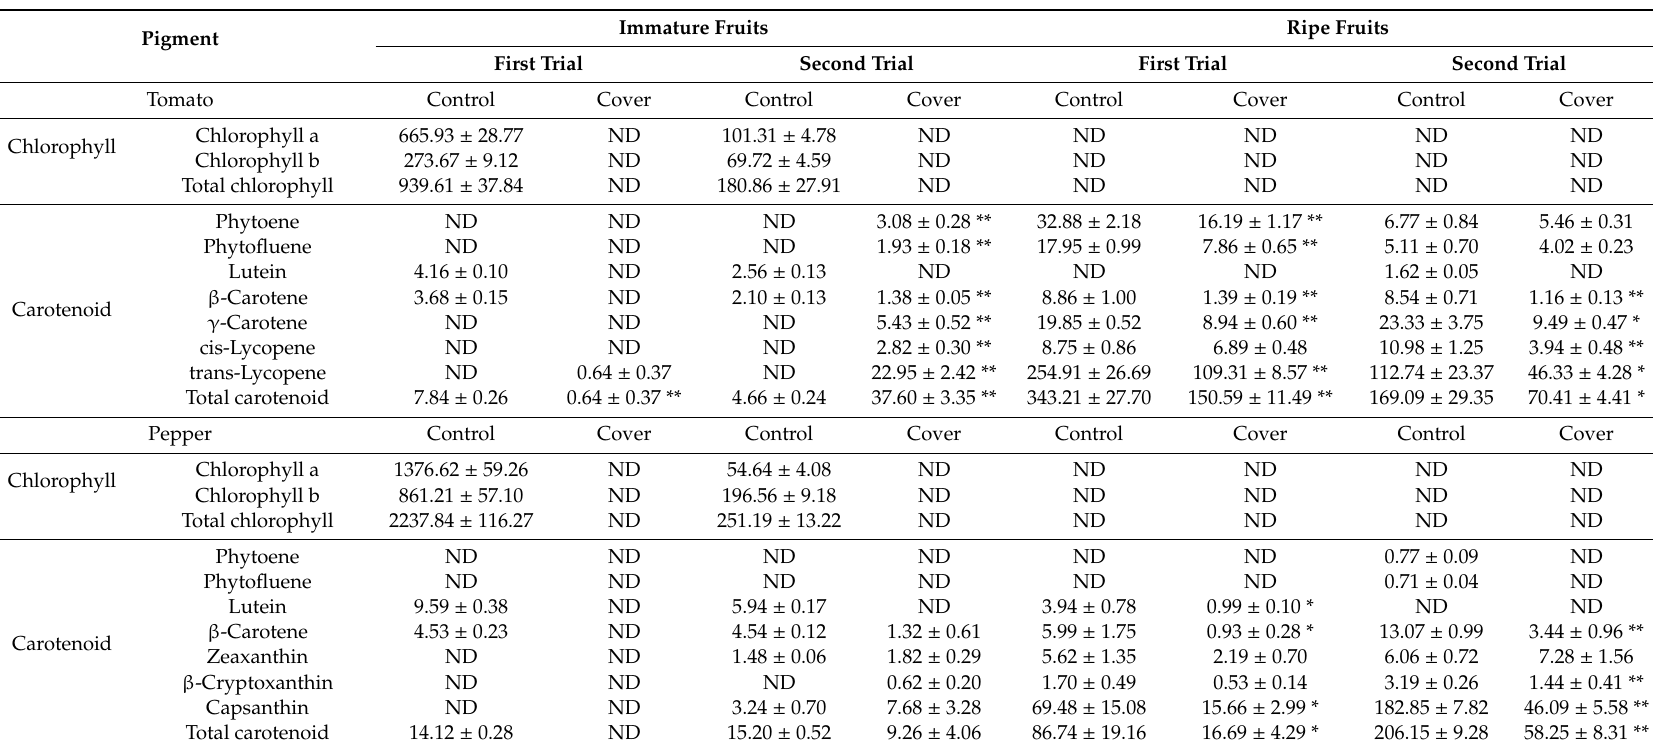
Table 1. Chlorophyll and carotenoid levels ( µ g g − 1 FW) in control (non-covered fruits) and covered tomato and pepper fruits. The data represents the mean of at least three biological replicates ± the standard error